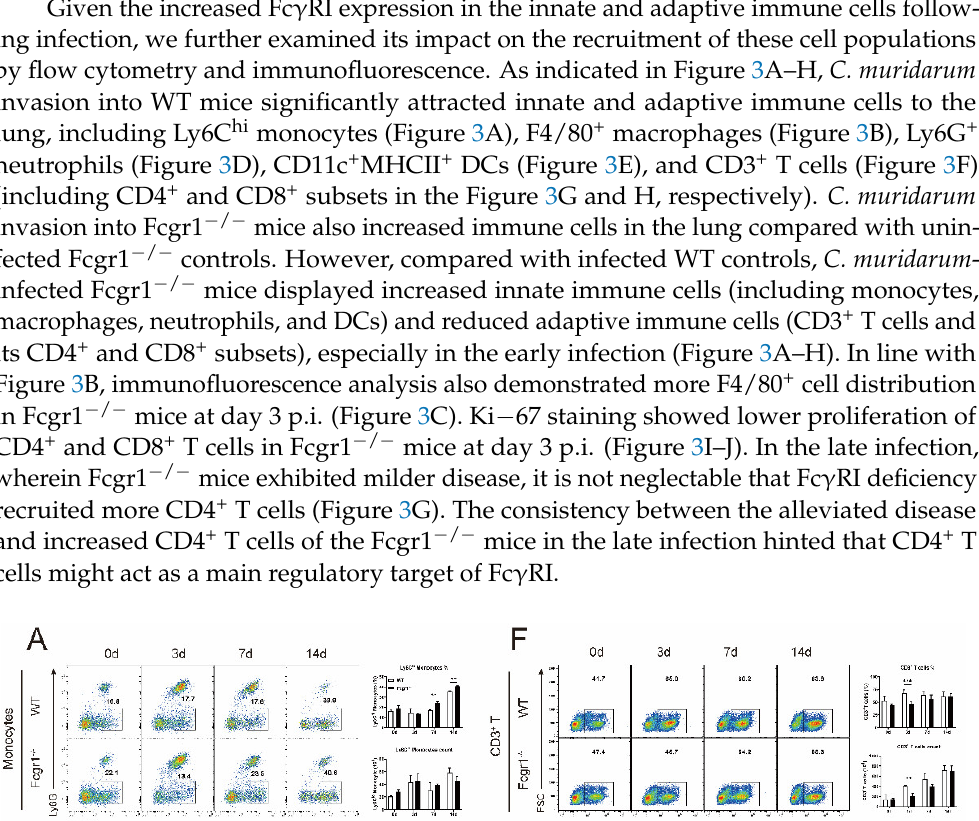
Figure 3. Altered numbers of innate and adaptive immune cells in Fcgr1 −/− mice after C. muridarum infection. The lung single cells of WT and Fcgr1 −/− mice on days 0, 3, 7, and 14 p.i. were prepared, and the infiltrations of innate and adaptive immune cells (gated as described in Supplementary Figure S1) were examined by flow cytometry. Representative flow cytometric plots ( left panel ), per- centages ( top right panel ), and total numbers of (bottom right panel) of Ly6C hi monocytes ( A ), mac- rophages ( B ), neutrophils ( D ), DCs ( E ), CD3 + T cells ( F ), CD4 + T cells ( G ), CD8 + T cells ( H ), Ki−67 + CD4 + T cells ( I ) and Ki−67 + CD8 + T cells ( J ) are shown. ( C ) The lung cryosections at day 3 p.i. were stained by anti-F4/80 for macrophages (green), and nuclei were stained with DAPI (blue), rep- resentative immunostaining captured by fluorescence microscopy in ×200 magnification. Data are represented as means ± SD from n = 3–5 per group, representative of one of three independent ex- periments. Statistical significances of differences are determined by two-way ANOVA. * p < 0.05, ** p < 0.01, *** p < 0.001, **** p < 0.0001. 3.4. Deficiency of FcγRI Promotes Th1 Response against C. muridarum Infection As widely reported, C. muridarum -induced Th1 response promotes chlamydial clear- ance through the production of IFN-γ [17,18]. We uncovered the regulation of FcγRI on CD4 + T cells in the above results, combined with the elevated FcγRI expression on CD4 + IFN-γ + Th1 cells in Figure 2H, and we further compared the C. muridarum -driven Th1 response in Fcgr1 −/− and WT mice. The flow cytometry analysis showed that both the pul- monary and splenic CD4 + T cells from Fcgr1 −/− mice produced significantly higher levels of IFN-γ (Figure 4A,B), reflecting increased Th1 responses in the local and systematic